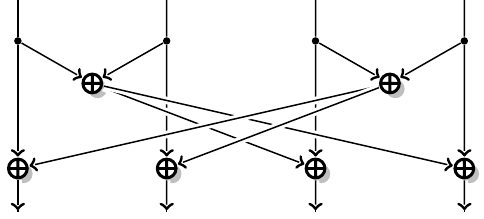
Figure 3: A circuit implementing the best 4 × 4 near-MDS